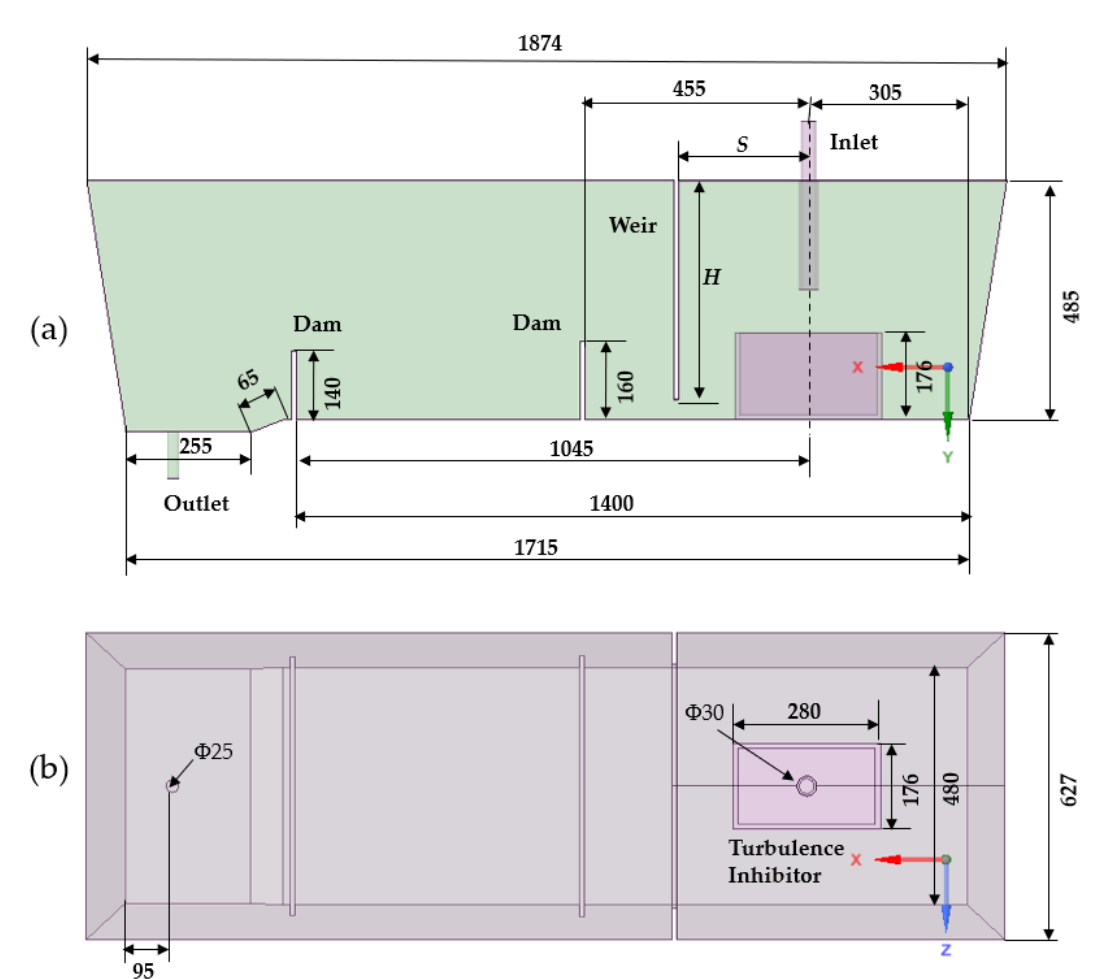
Figure 3. Geometry of water model: ( a ) front view ( b ) top view (unit: mm).